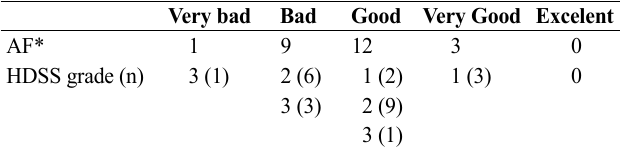
Table 1: Hyperhidrosis Disease Severity Scale (HDSS) of 25 physical education students with primary hyperhidrosis at a private university in Aracaju-SE, from August to November 2017.